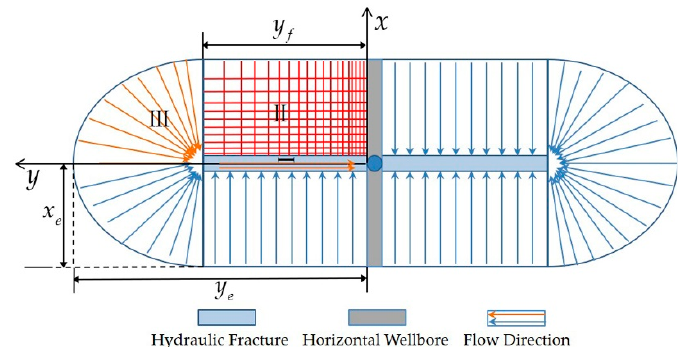
Figure 3. Plane figure of fluid seepage in a primary fracture and the surrounding reservoir.